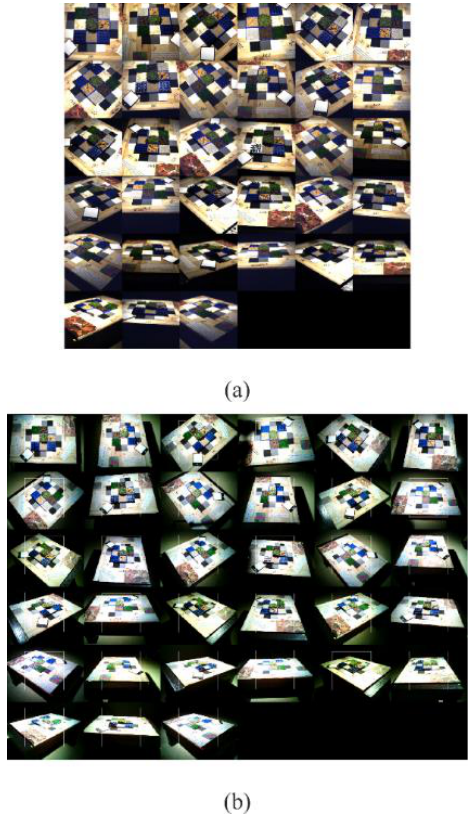
Figure 3 . Set of 33 RGB images (a) and spectral images (b) from the vertical image through images of Zenith 30, 45, 60, to 70